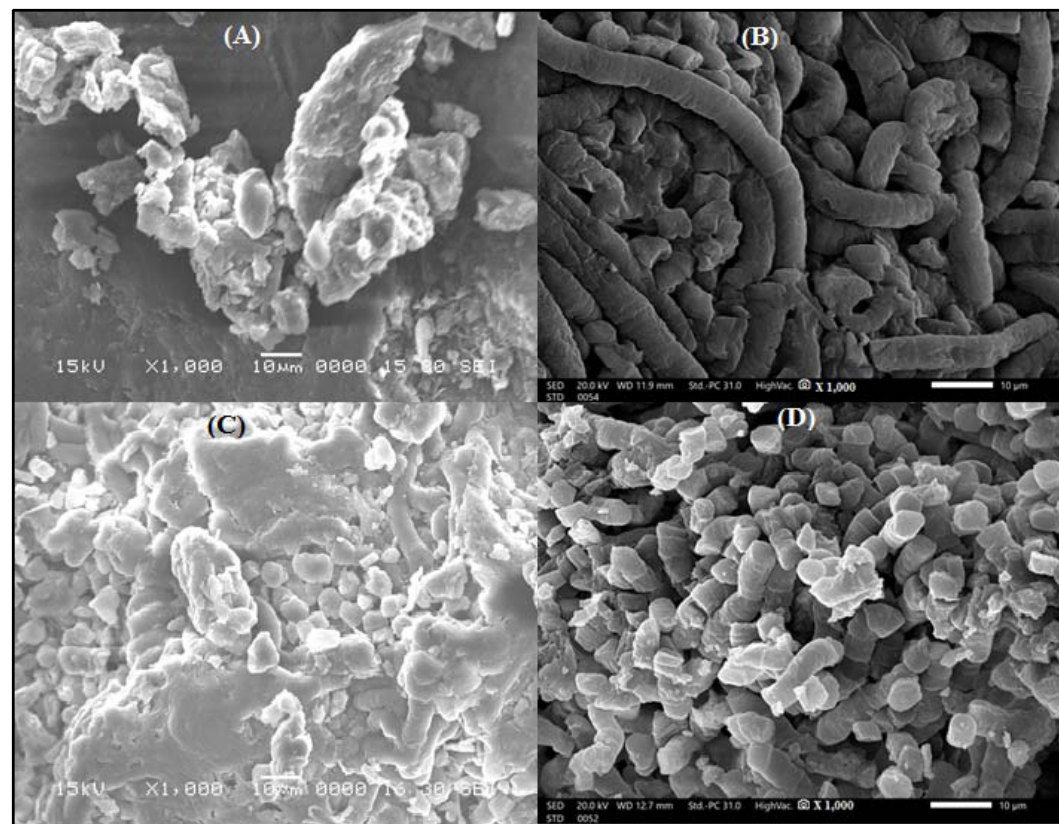
Figure 3. SEM pictures of ACDW before adsorption ( A ), ACDW after adsorption ( B ) and LFB before adsorption ( C ), and LFB after adsorption ( D ).